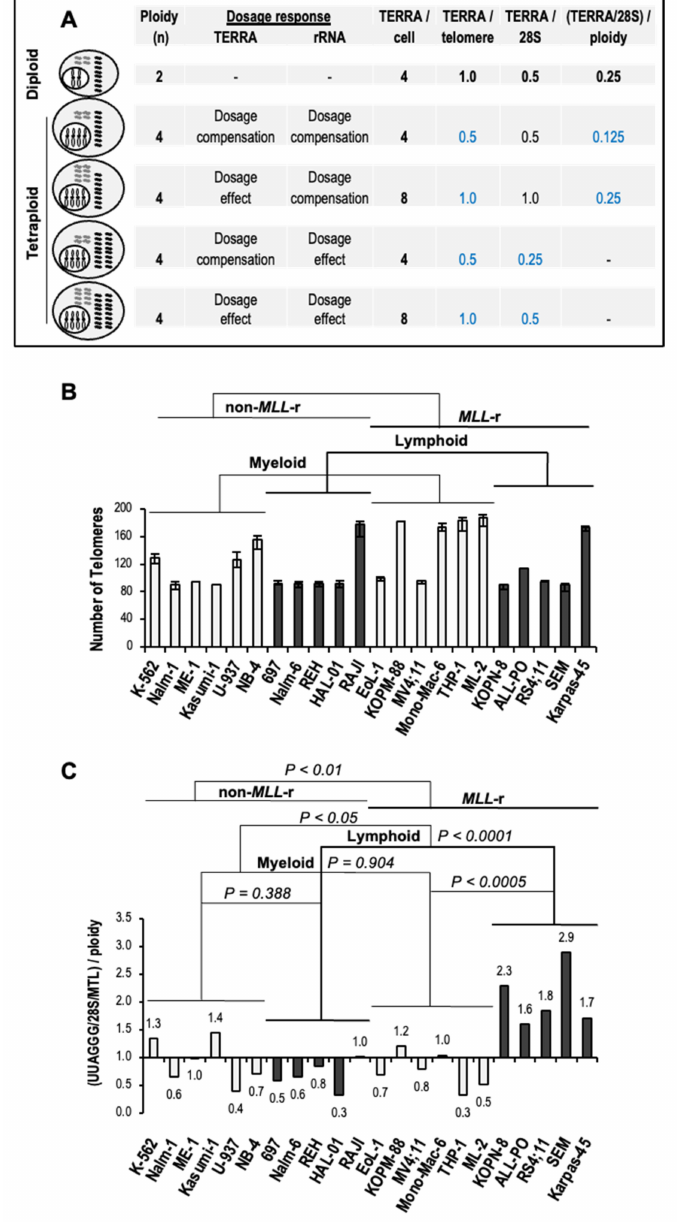
Figure 5. Increased TERRA levels in MLL-r ALL are independent of ploidy. ( A ) Potential TERRA dosage response in tetraploidy. The effects of chromosome set quadrupling (gray rods in the nucleus) on telomere transcription relative to diploid cells can go from dosage compensation, with no change in TERRA levels (gray wavy lines); to a 1:1 dosage effect, with a doubling in TERRA levels per doubling of telomeres; or intermediate responses (not illustrated). The same goes for rRNA (black wavy lines). In tetraploid cells with rRNA dosage compensation, TERRA levels per cell (TERRA/cell) correlate well with transcriptome-normalized TERRA levels (TERRA/28S) when compared to diploid cells, regardless of TERRA dosage response. TERRA levels per telomere (TERRA/telomere) are inferred from TERRA/28S when divided by ploidy. In tetraploid cells with a 1:1 rRNA dosage effect, TERRA/28S is directly correlated with the TERRA/telomere. ( B ) The total number of telomeres in each analyzed myeloid (light columns) and lymphoblastic (dark columns) leukemia cell line